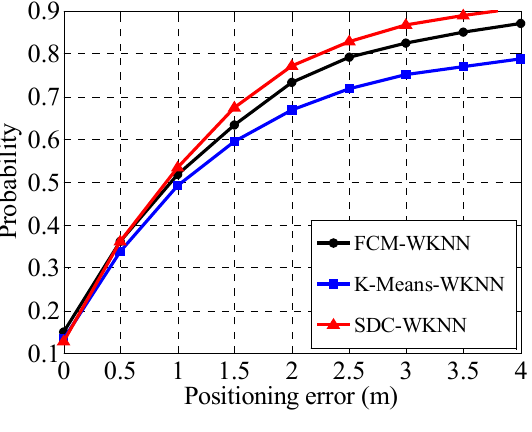
Figure 10. Positioning accuracies based on Coarse Positioning